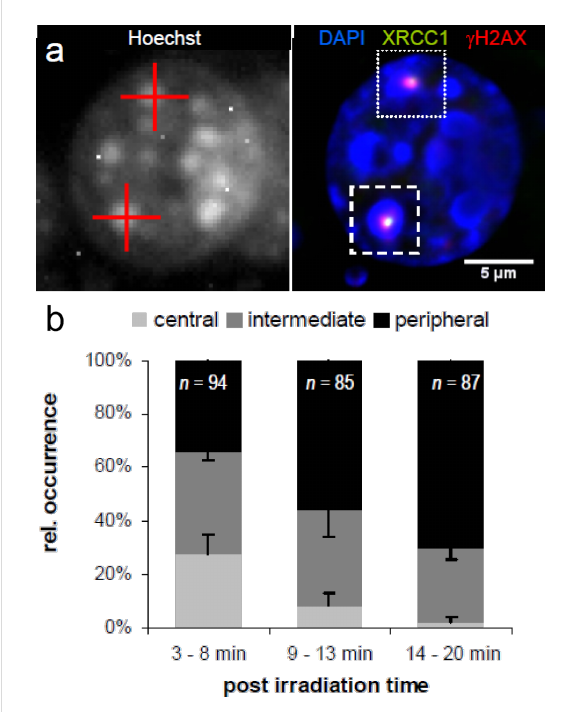
Figure 2: Relocation dynamics of damage sites centrally induced within heterochromatic chromo centers. (a) The mouse embryo fibrob- last (MEF) nucleus was irradiated with single sulfur ions and immunos- tained 5 min after irradiation. H2AX is phosphorylated and the repair protein XRCC1 accumulates at heterochromatic DSBs directly after single-ion irradiation. The left-hand image shows the aimed targeting of chromo centers (red crosses) for single-ion irradiation by using Hoechst 33342 (grey scale) as a marker in the nuclei of living MEF cells. The right-hand image shows the same nucleus after fixation at 5 min after irradiation. DNA-damage-induced foci of the repair factor XRCC1 (green) and γ H2AX (red) are clearly visualized at the sites of ion traversal. Both proteins colocalize within each of the targeted chromo centers (blue: DAPI DNA staining). (b) Analysis of the time- dependent localization of XRCC1 and γ H2AX radiation-induced foci. Relative frequencies of each position are given for the indicated post- irradiation intervals and (n), the total number of ion-hit chromo centers from three independent experiments, is indicated. Error bars represent the SEM. Figure adapted from